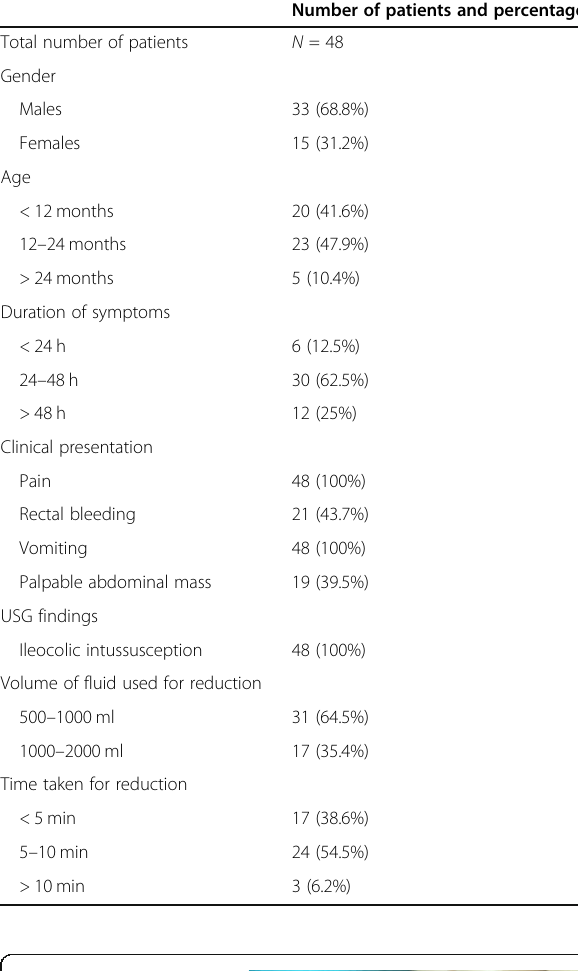
Table 1 Demographic profile, clinical presentation, and procedure information